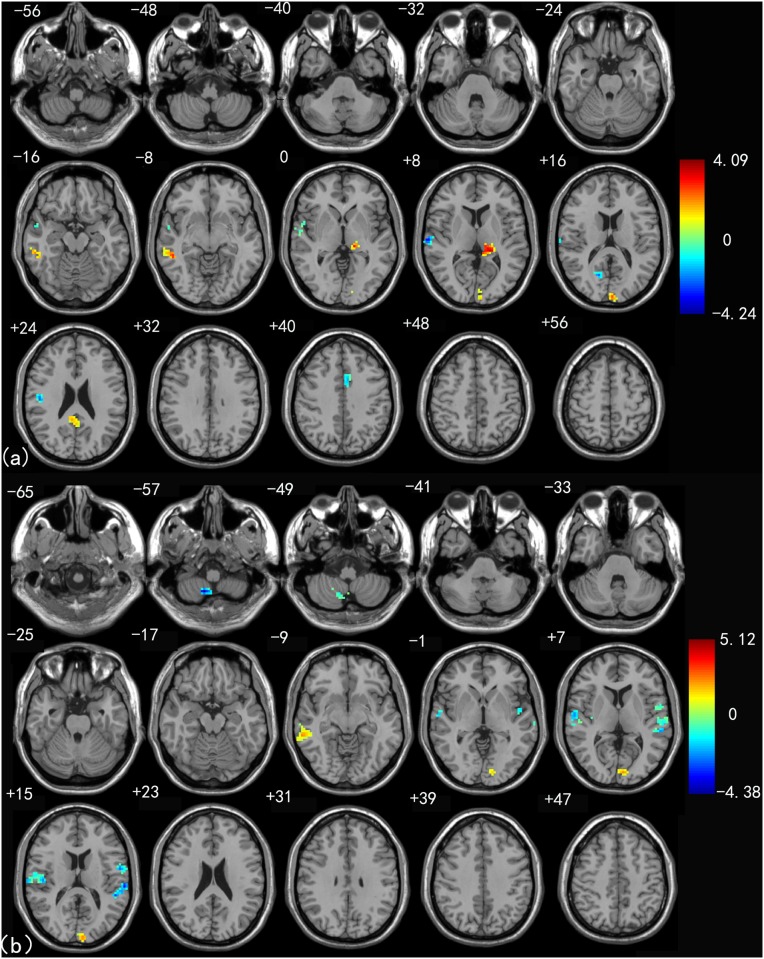
Left (a) and right (b) thalamus connectivity difference maps between the EMCI patients and healthy control group (P < 0.01, 40 voxels, Alphasim corrected).